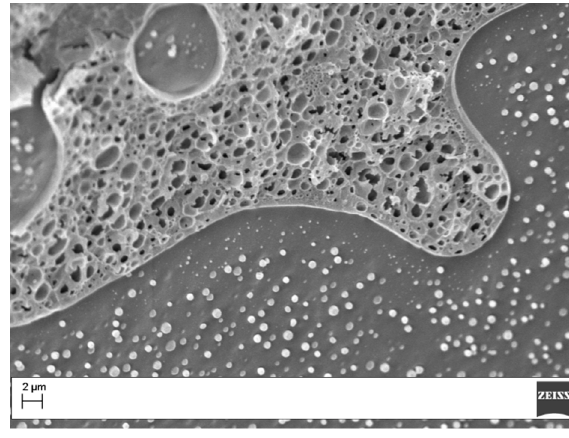
Figure 7. SEM image of the post-cured sample modified with 20 wt% of coPES (magnification 5000×).